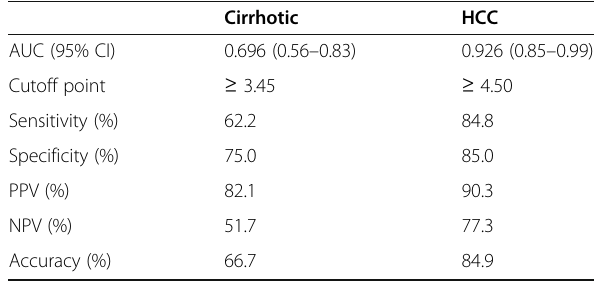
Table 4 ROC curve of AFP in the total studied